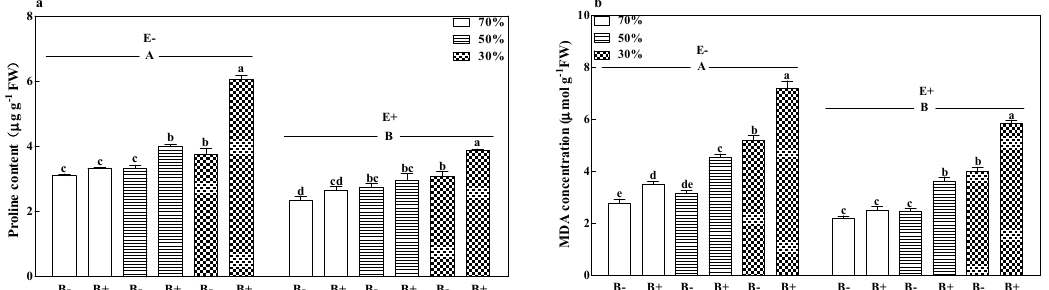
Figure 6. Proline content ( a ), and malonaldehyde (MDA) concentration ( b ) of perennial ryegrass infected with (E + ) or without (E − ) fungal endophyte and inoculated (B + ) or noninoculated (B − ) with pathogen at 70%, 50%, and 30% soil water regimes at harvest. Mean ± SEM of four replicates are shown. Bars topped by the same lower case letter indicate no significant di ff erence between soil water regimes and pathogen within fungal endophyte treatments at p ≤ 0.05 by Tukey’s HSD test. Bars topped by the same upper case letter indicate no significant di ff erence associated with fungal endophyte at p ≤ 0.05 by Tukey’s HSD test.